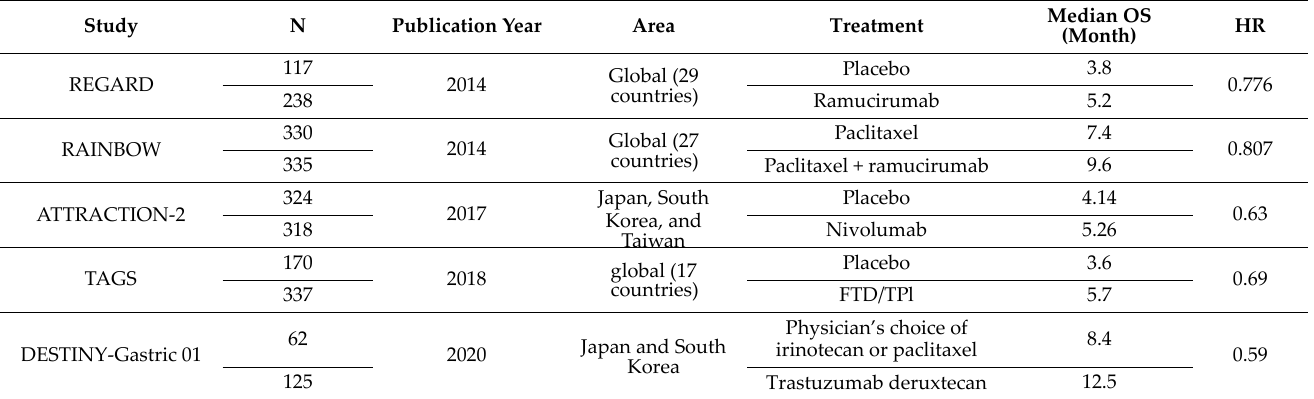
Table 3. Pivotal randomized controlled clinical trial for second‑line and subsequent chemotherapy for gastric